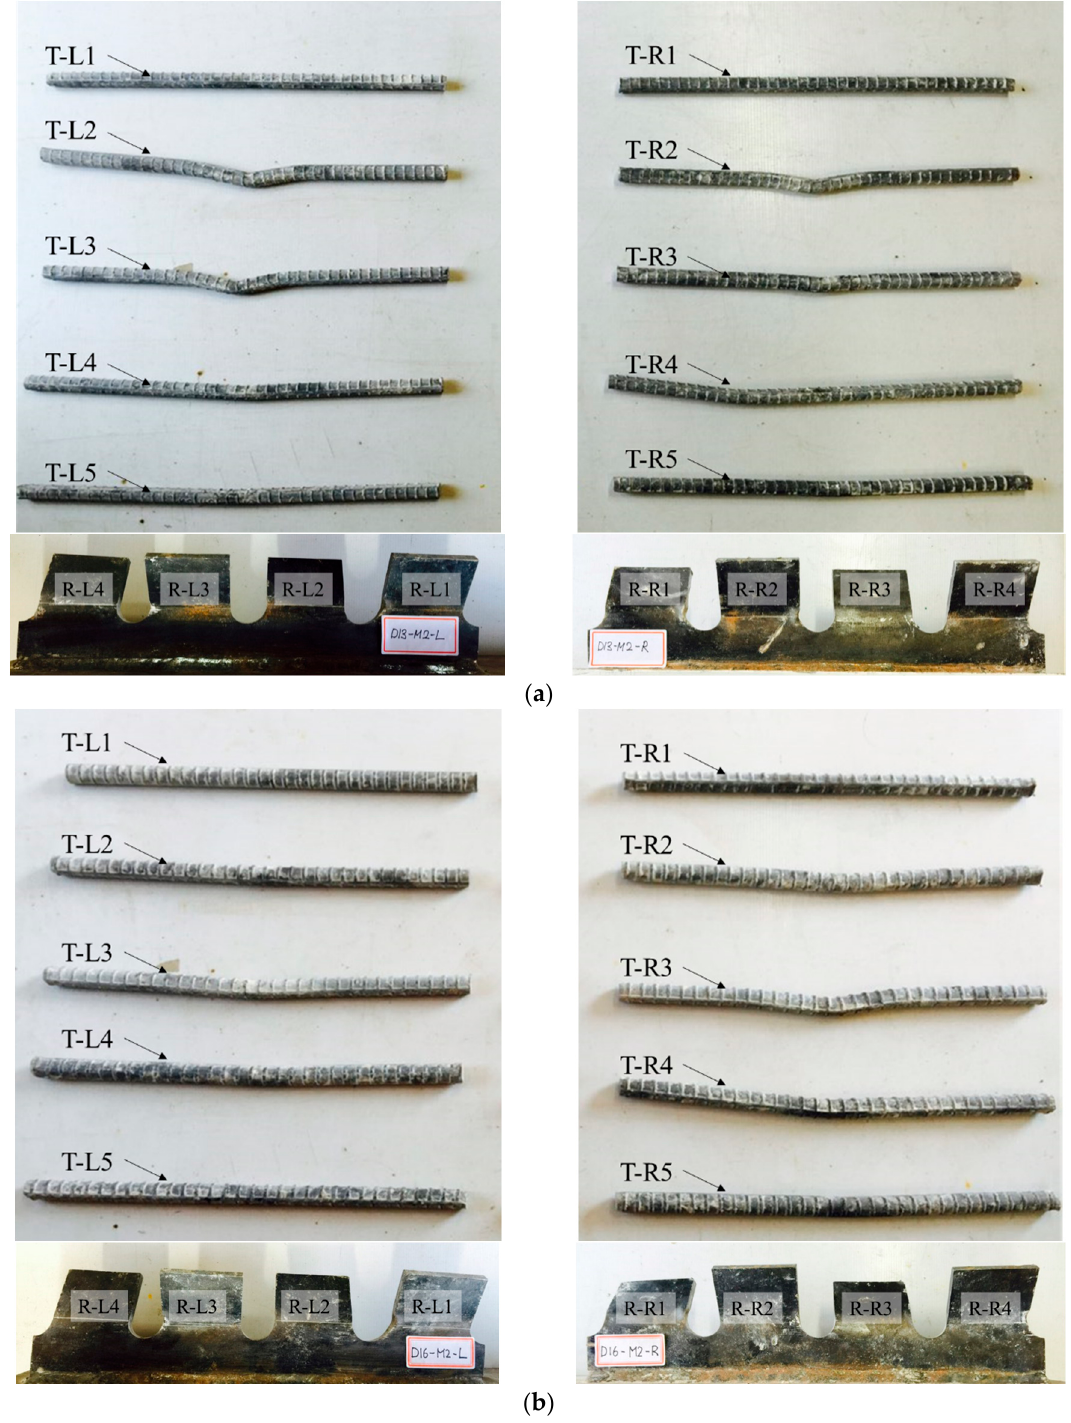
Figure 11. Deformation of transverse rebars and ribs; Stage 4: ( a ) SY-D13-M2; ( b ) SY-D16-M2.